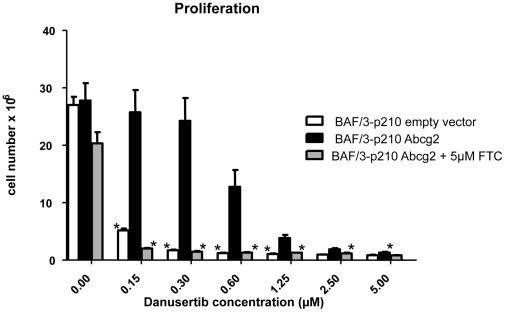
Retroviral overexpression of Abcg2 altered the sensitivity to Danusertib.Overexpression of Abcg2 in parental Ba/F3-p210 cells protects them against cytotoxic effects of Danusertib treatment. Ba/F3-p210 cells transduced with Abcg2 or with control empty vector were exposed for 48 hours to the indicated concentrations of Danusertib. In addition, the Abcg2-overexpressing Ba/F3-p210 cells were treated in the same way in the presence or absence of 5 µM FTC, a specific inhibitor of Abcg2 activity. In all experiments the number of viable cells was analyzed with Vi-CELL XR. Bar graphs represent the mean of three (empty vector and Abcg2) or six (Abcg2+5 µM FTC) experiments ± S.D. and asterices indicate p<0.05. Significance was determined using t-test.